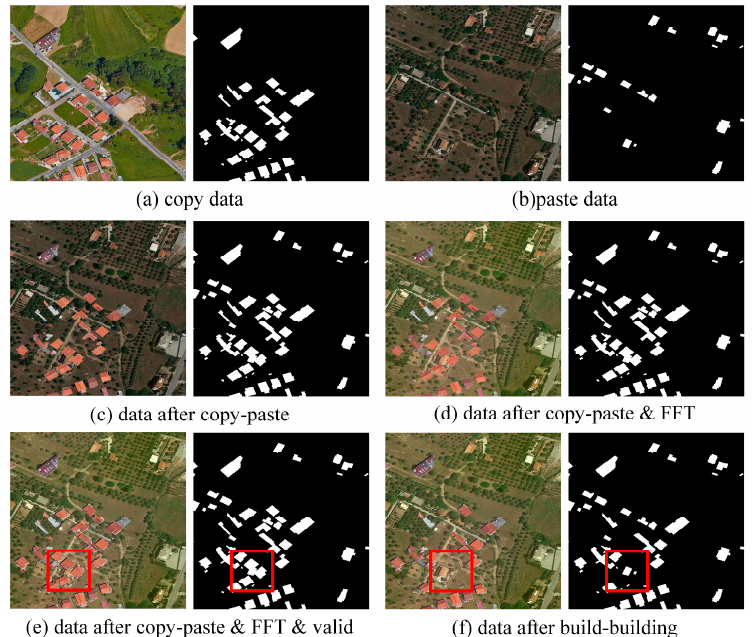
Figure 6. Example results of each stage of build-building. Among them, the red box area is the focus